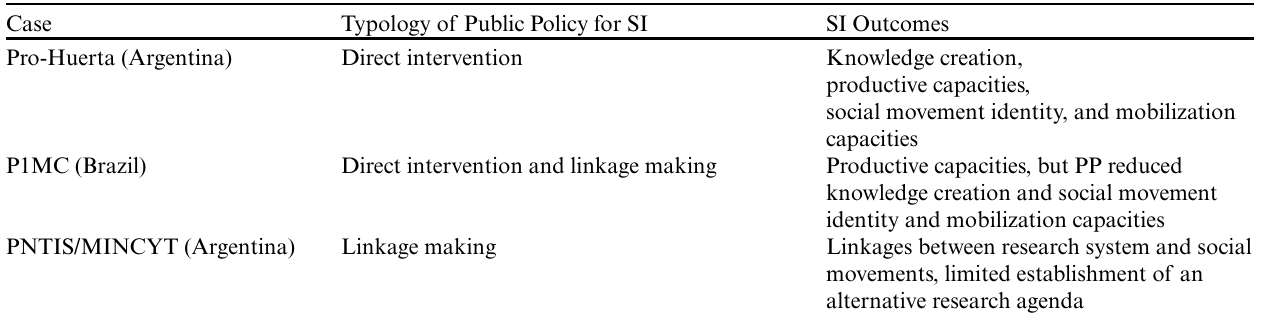
Table 1 . Case-study summary and